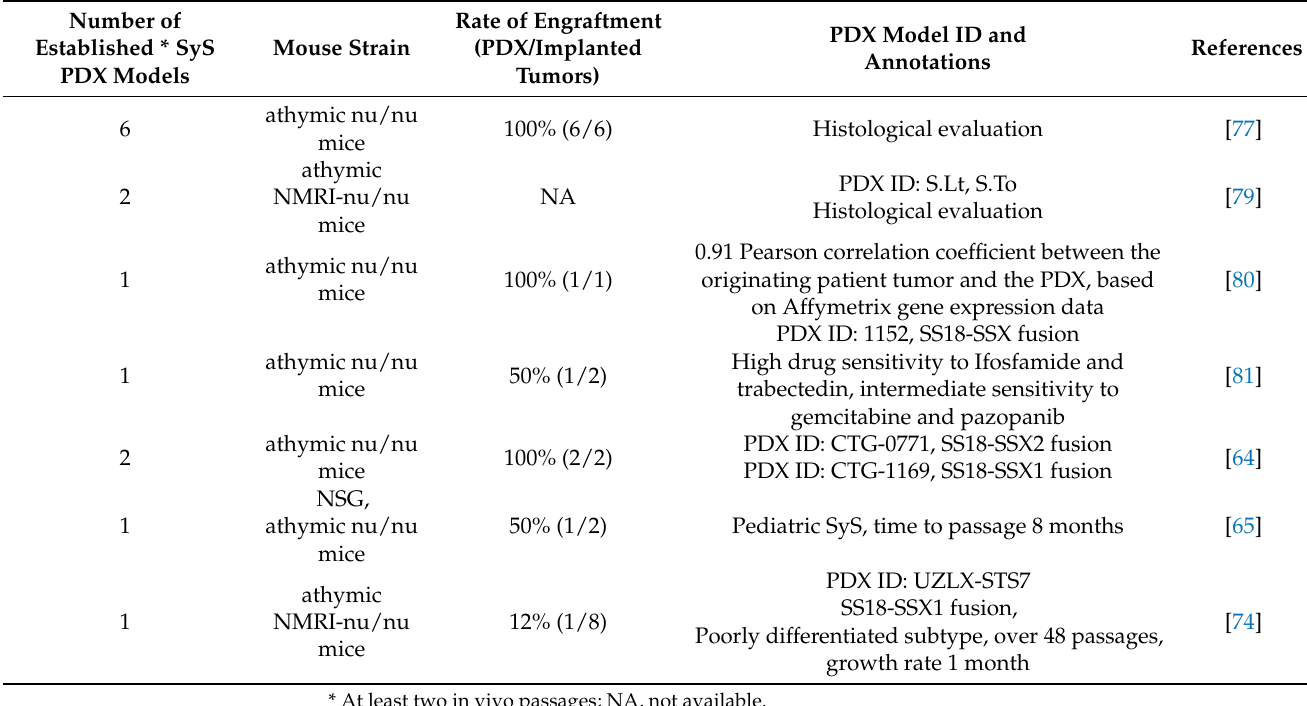
Table 4. SyS PDX models in most relevant published collections.